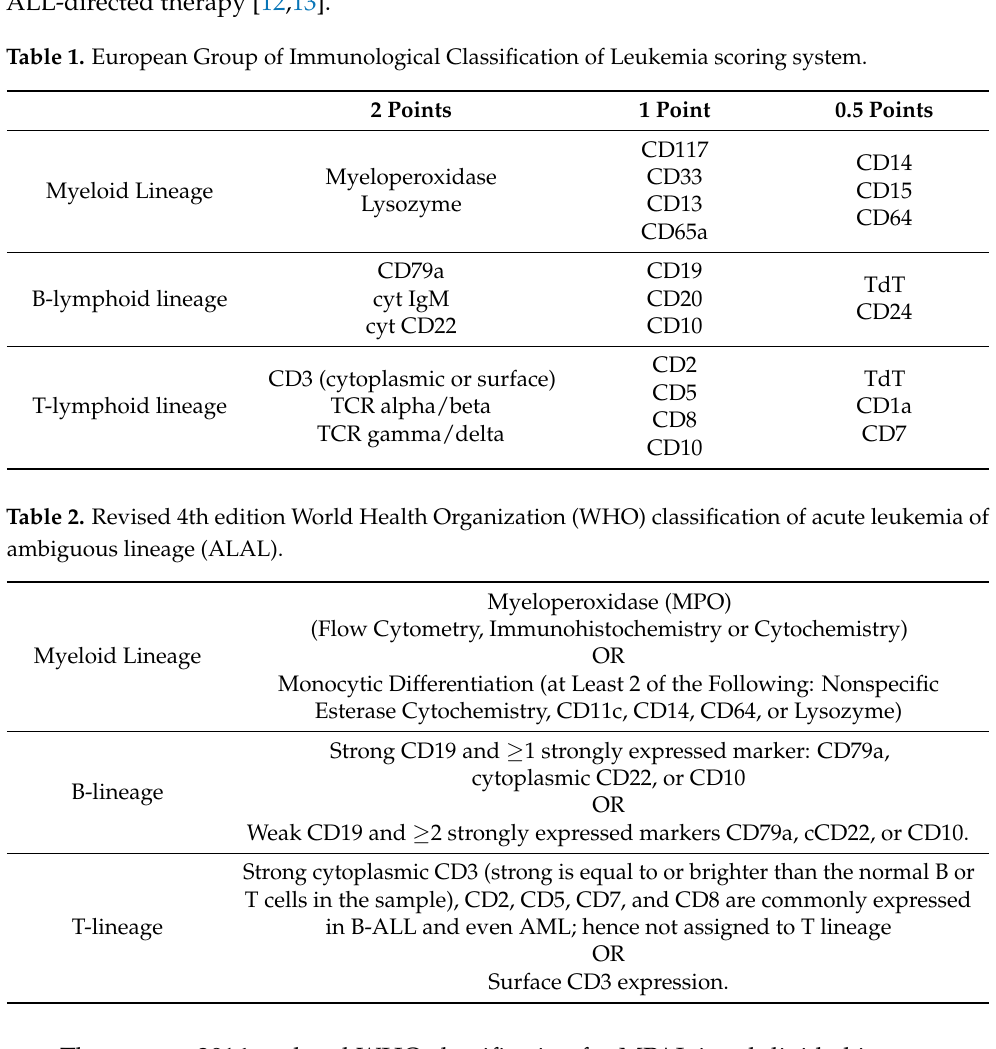
Table 3. Revised 4th edition World Health Organization (WHO) classification of mixed-phenotype acute leukemia (MPAL). MPAL MPAL, B/myeloid, NOS MPAL, T/myeloid, NOS MPAL, NOS, rare types (T/B/myeloid) MPAL with gene arrangements MPAL with t(9;22) (q34.1;q11.2); BCR-ABL1) MPAL with t(v;11q23.3);